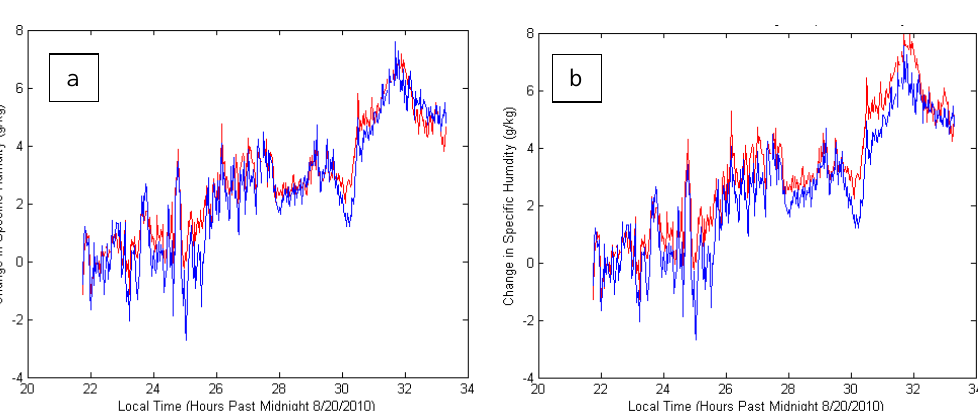
Fig. 10. (a) Conversion to specific humidity using the AM model. (b) Conversion to specific humidity using the MPM 93 model. The 22.6GHz and 23.5GHz channels are red and blue